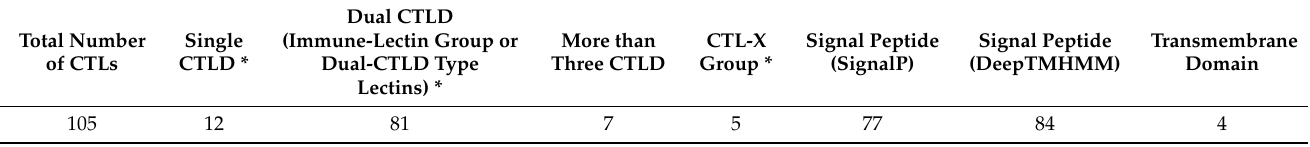
Table 5. Summary of CTL